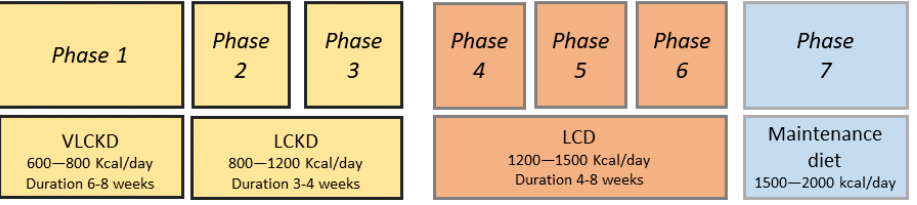
Figure 1. Phases of very low-calorie ketogenic diet (VLCKD) protocol. LCKD: low-calorie ketogenic diet. LCD: low carbohydrate diet.